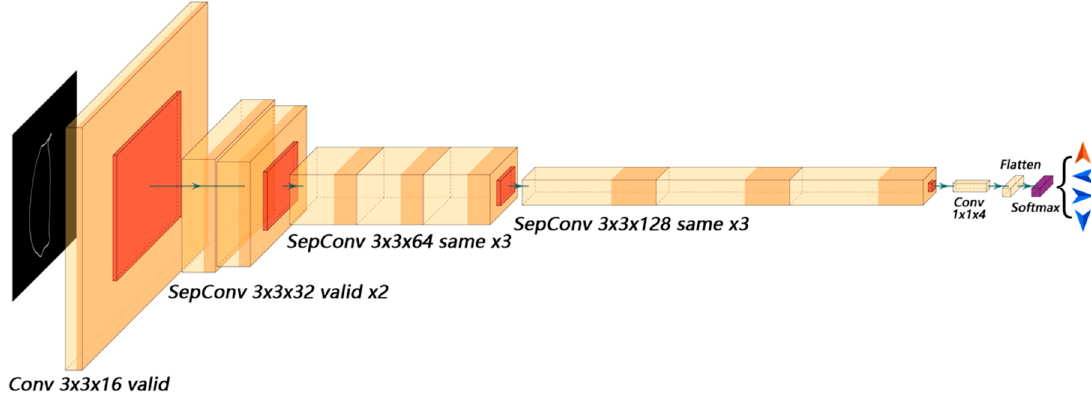
Figure 14. Naive CNN model after